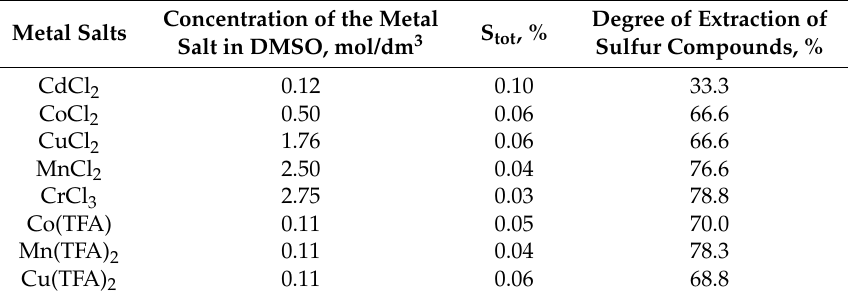
Table 3. Extraction of sulfur compounds from the fraction boiling in the temperature range of 200–350 ◦ C with saturated solutions of chlorides and metal trifluoroacetates in DMSO. The total sulfur content (S tot ) in the initial sample is 0.2%. S tot content in the initial sample after treatment with DMSO is 0.18%. The extraction time is 30 min. The temperature is 25 ◦